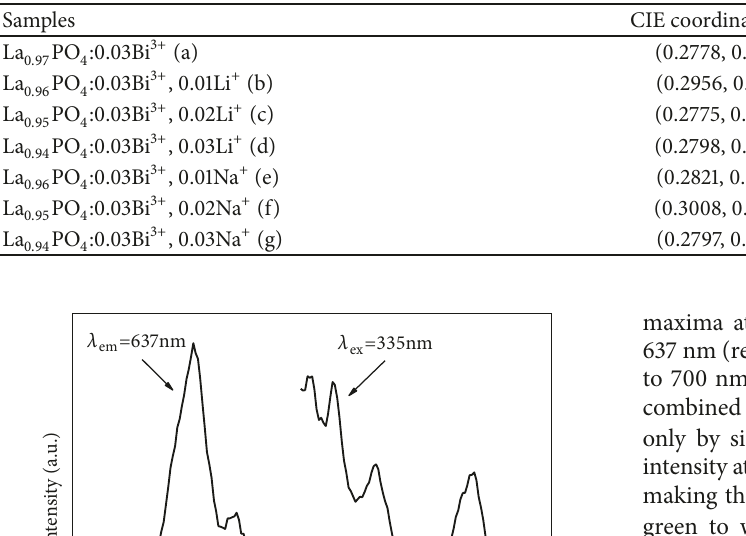
Figure 3: SEM images of La 0.97 PO 4 :Bi 3+ 0.03 samples after calcination at 1200 ∘ C for 8 h. Table 1: The color coordinates of various color concentrations of the samples and correlated color temperature.